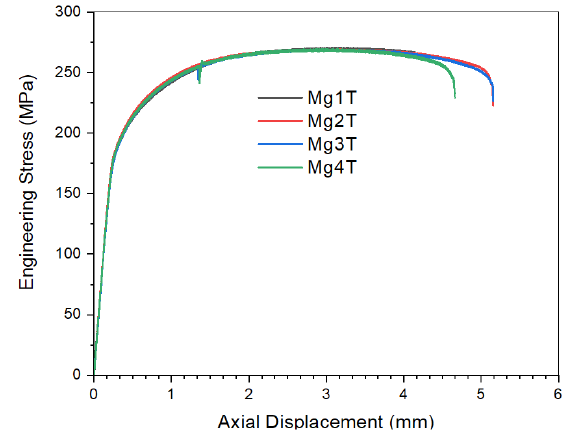
Figure 5. The relationship between the stress incremental and the change in specimen